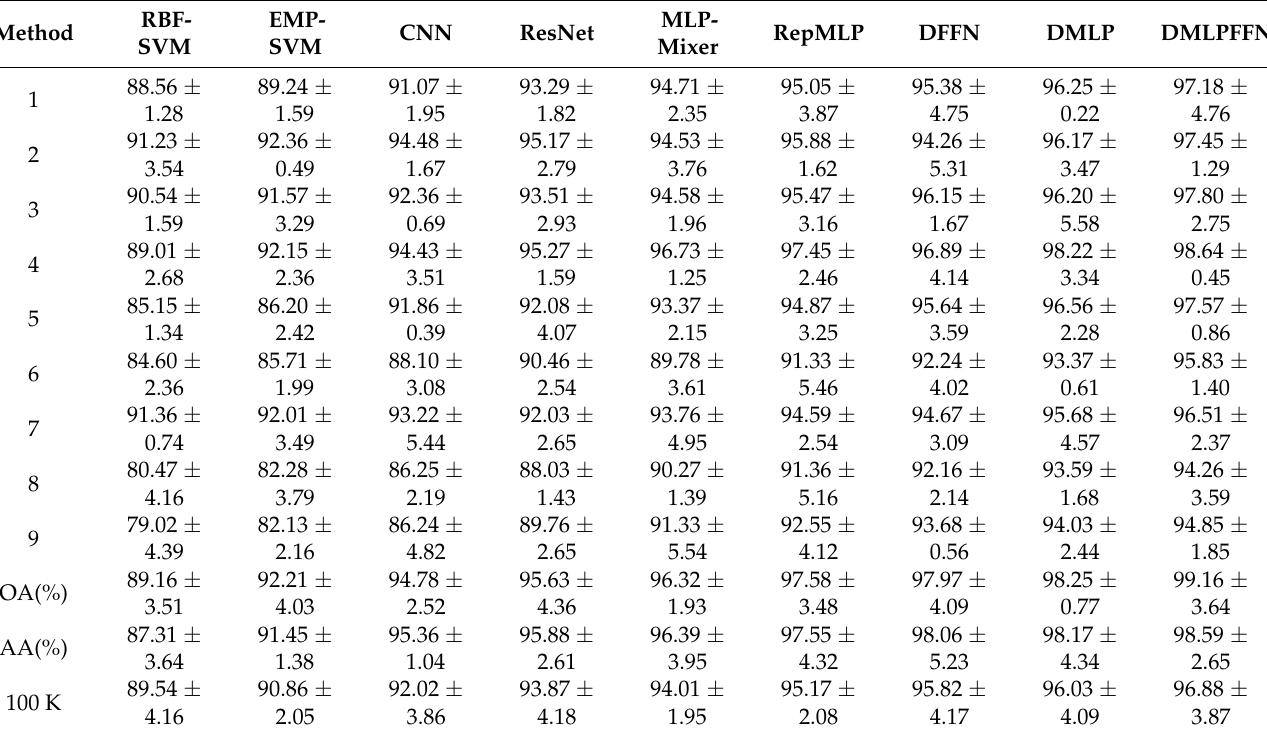
Table 8. Classification results on the LongKou dataset by different classification methods.